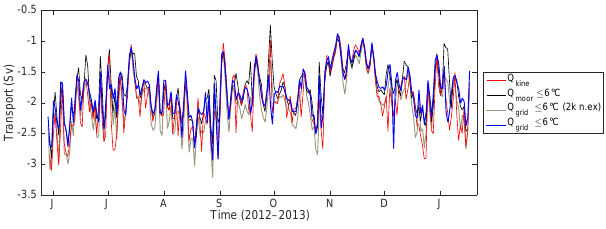
Figure B1. Time series of volume transport at mooring section C computed by different methods: kinematic ( Q kine ), per mooring ( Q moor ), and from gridded fields ( Q grid ). The latter two methods allow calculation of transport by temperature range, and results are shown here for the ≤ 6 ◦ C temperature class. The grey line repre- sents a version with a 2km horizontal grid and no upward extrap- olation (which led to data from the longest, central mooring domi- nating the upper levels of the grid), and the blue line is the version used to produce the values of Q grid reported in Sect.